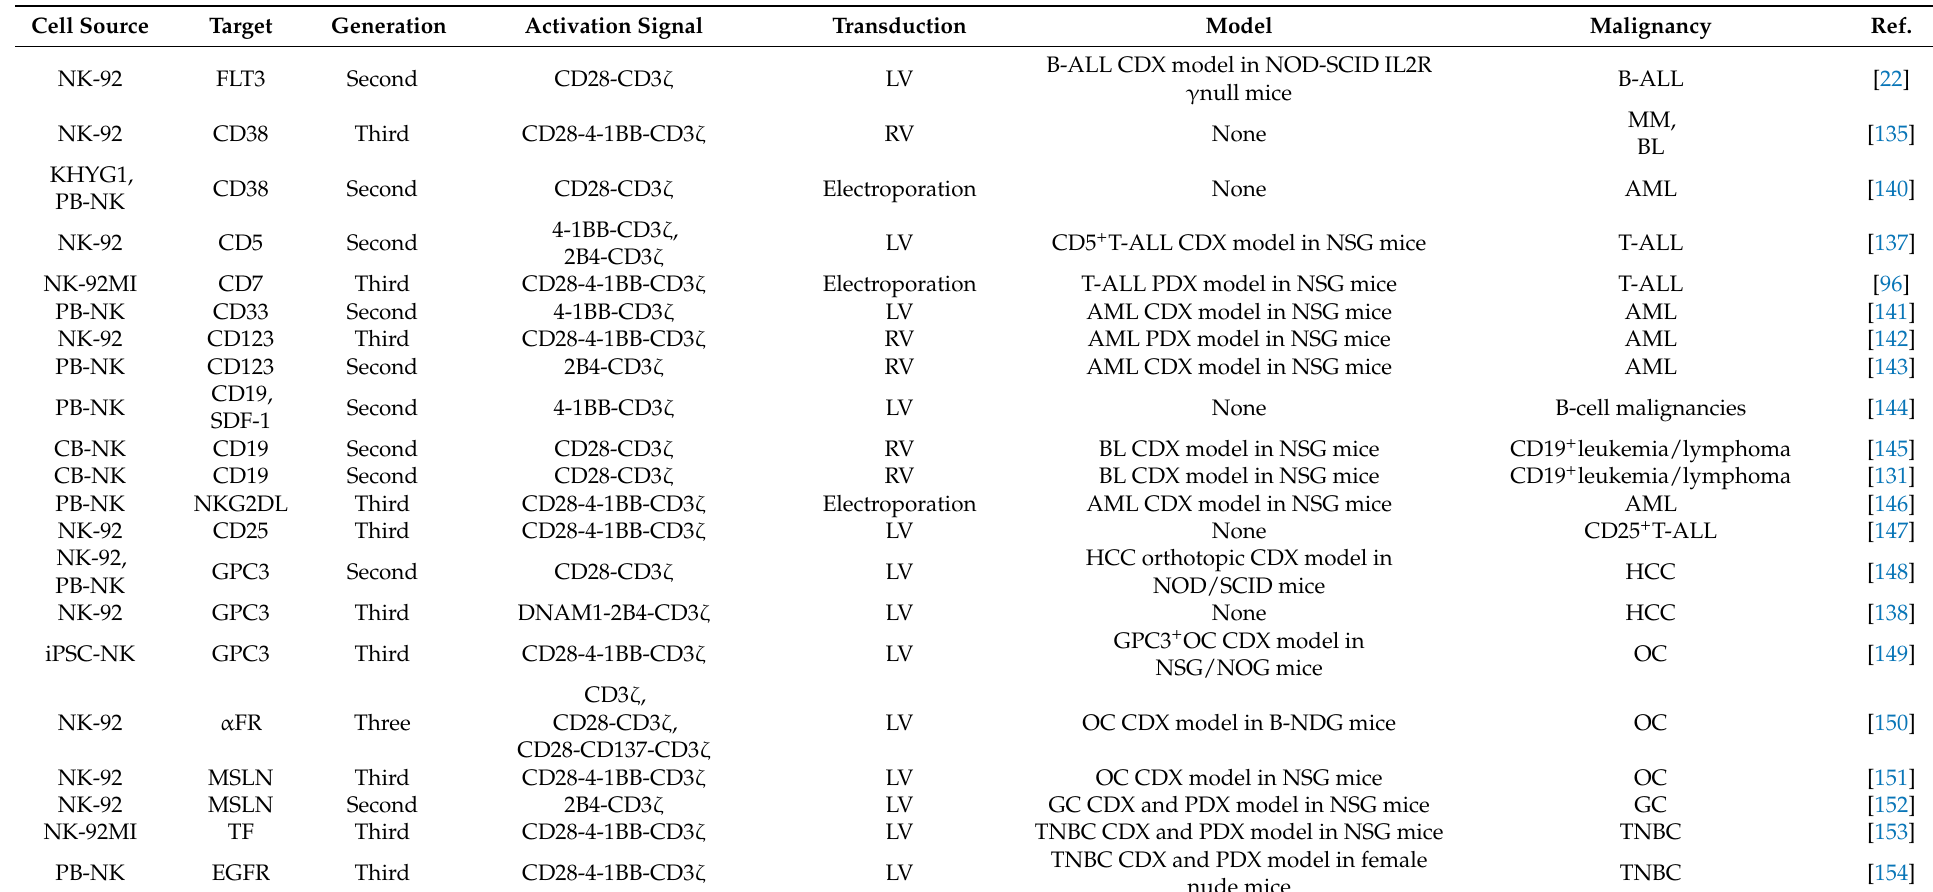
Table 1. Current CAR NK cell